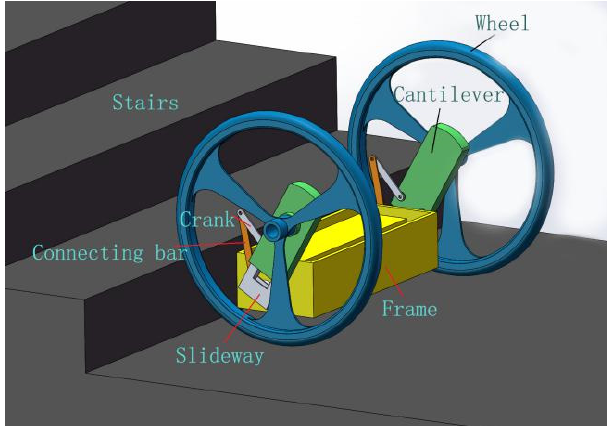
Figure 9. Simulation model of the prototype.